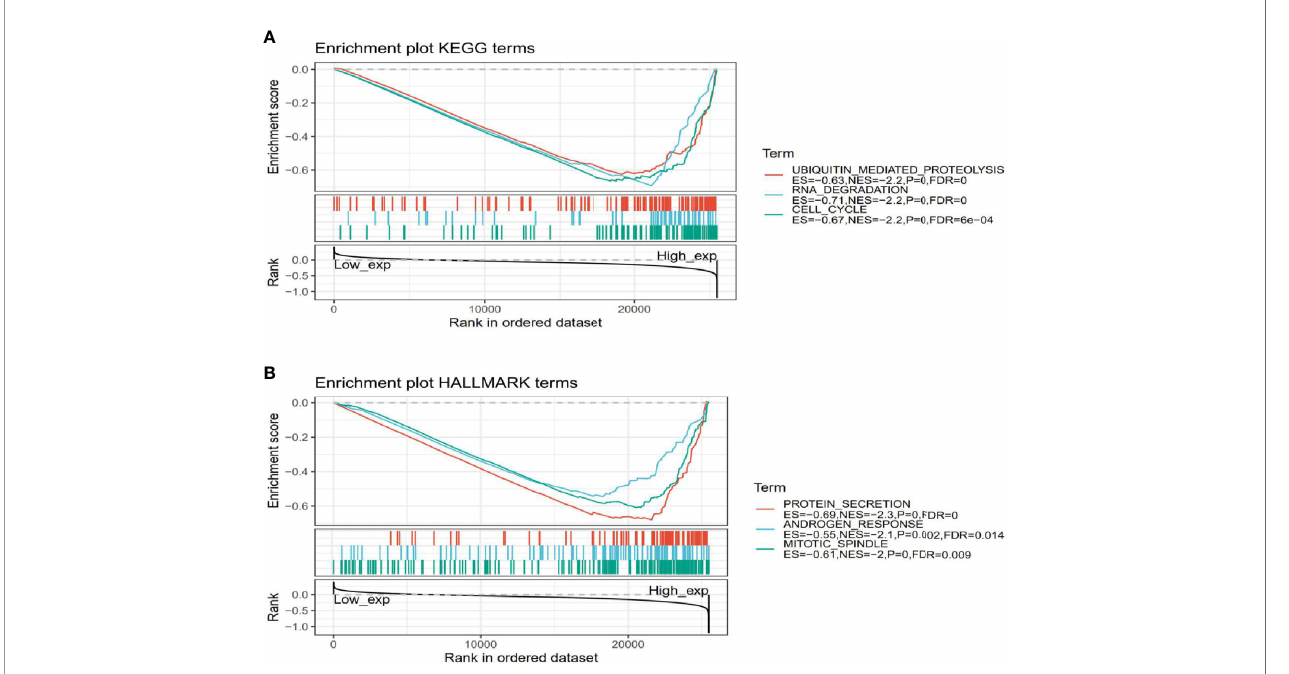
FIGURE 8 | Gene set enrichment analysis of ATG5 associated with signaling pathways in KEGG and hallmark datasets. (A) Results of GSEA of ATG5 ranked in the top 3 for its correlation with signaling pathways in KEGG database. (B) Results of GSEA of the top 3 rankings of ATG5 correlation with signaling pathways in hallmark